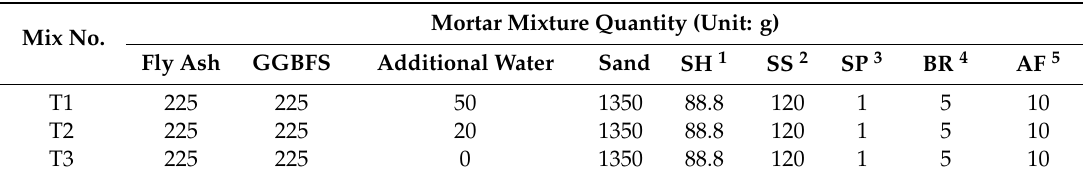
Table 2. Details of geopolymer mortar mix proportions.